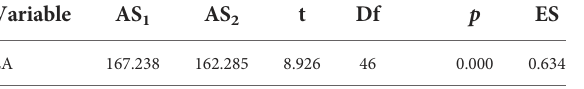
TABLE 2 In fl uence of SB load on LA size change in